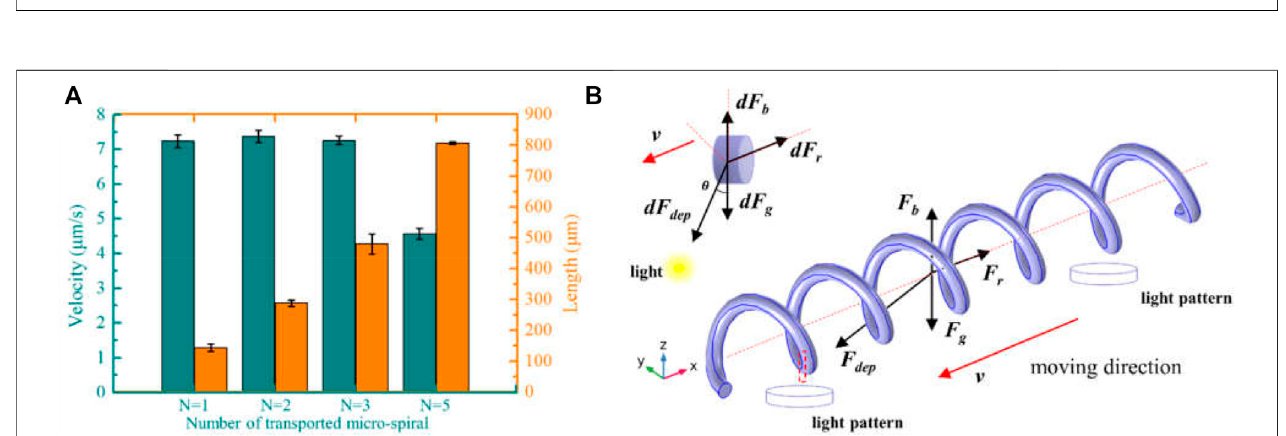
FIGURE 5 | (A) Manipulation velocity of the different length of micro- spirulina . (B) An analysis of the manipulated force of micro-spiral in an OET.